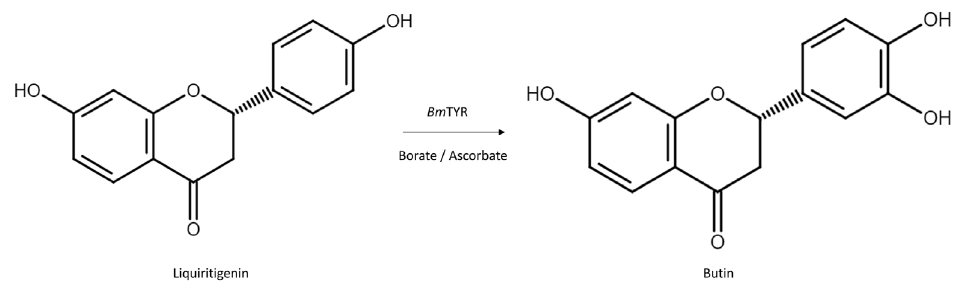
Figure 6. The biotransformation of liquiritigenin catalyzed by Bm TYR.